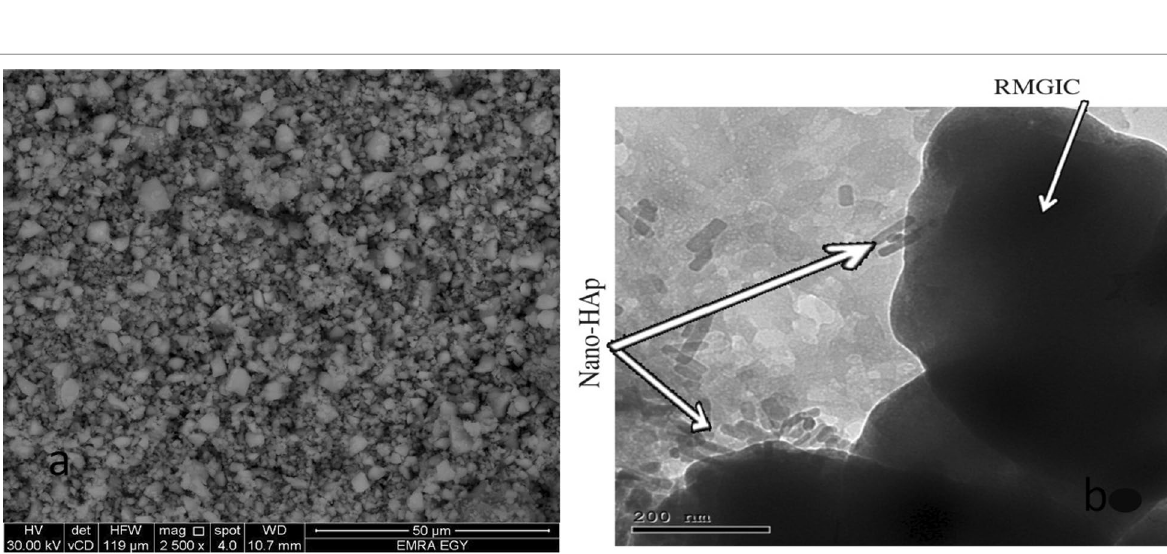
Fig. 6 SEM ( a ) and TEM ( b ) photomicrographs for the prepared nano-HA-RMGIC